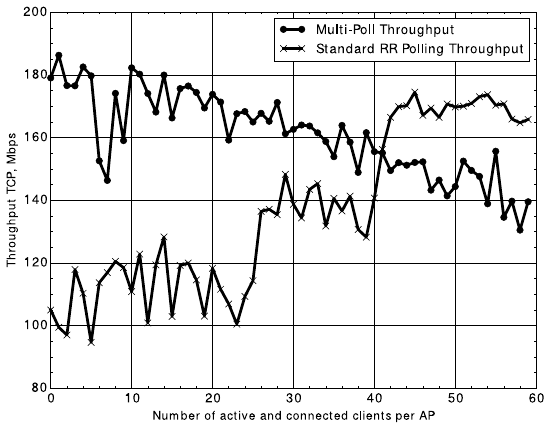
Fig. 4. Performance with different numbers of clients per AP.